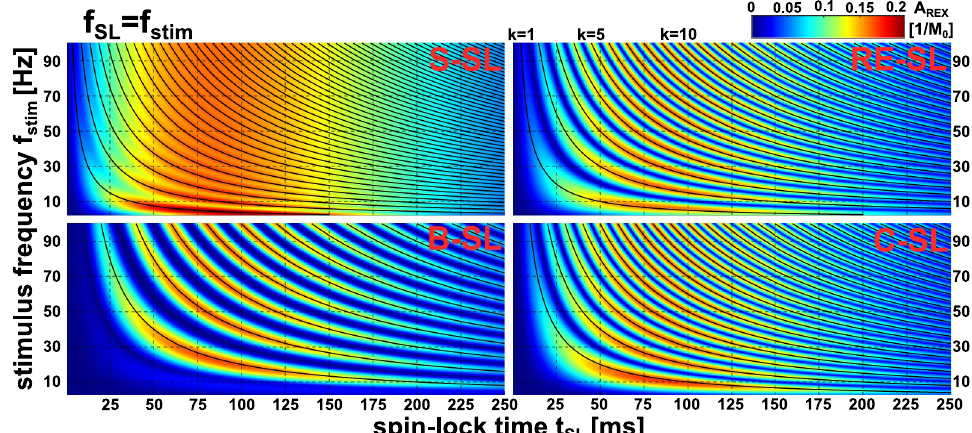
Figure 3. Simulation of A REX sensitivity for different spin-lock preparation modules at various frequencies in the resonant case (f stim = f SL ) and various spin-lock pulse durations t SL . Depending on the resonance frequency, a different spin-lock pulse duration is suitable for maximizing A REX . The stimulus frequency f stim was varied from 2.5…100 Hz in 0.5 Hz steps and the REX resonance condition f SL = f stim was considered. (cid:31) B stim 0 = 50 nT was assumed and t SL was varied from 0.5…250 ms in 0.5 ms steps. The black line shows the k-th maximum calculated by the empirically derived prediction law (Eq. 4). For the S-SL module, the maxima are less sharply defined than in the case of the compensated modules. The results show that a parameter choice matched to the stimulus frequency is of high importance for maximizing A REX . These results were used for a detailed parameter optimization and to build the basic framework for the t SL choice in the phantom and in vivo measurements carried out in this